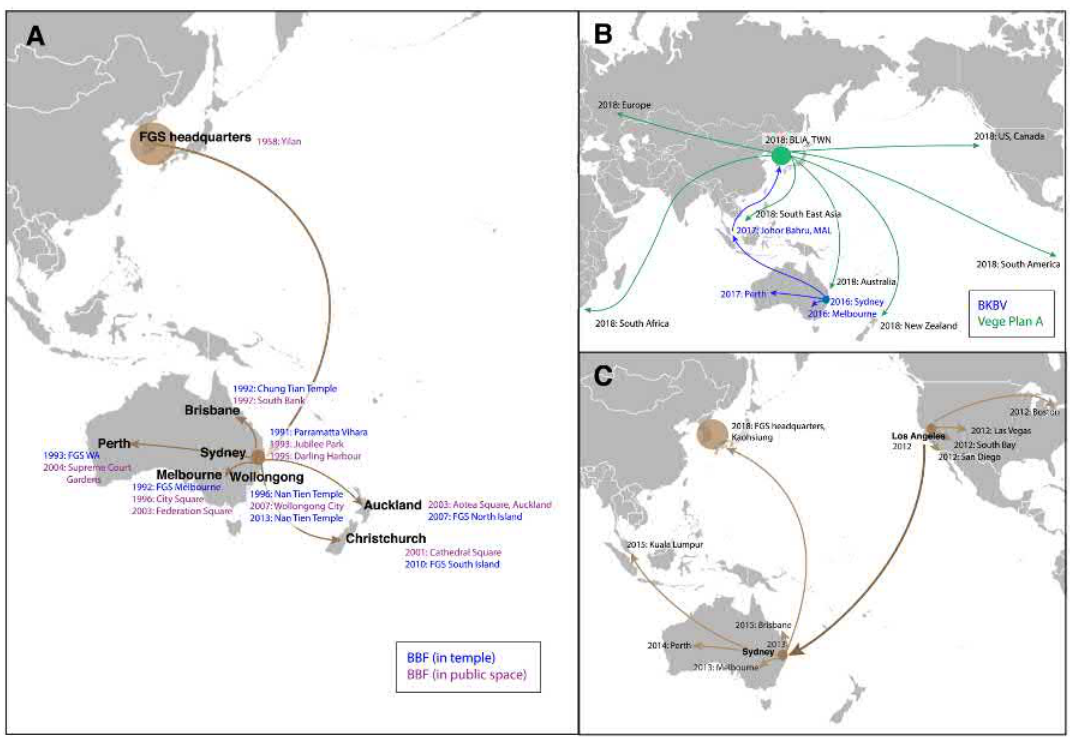
Figure 3: Multidirectional flows in the FGS network. A . Flow from FGS headquarters in Taiwan to its regional centre and branchtemplesinAustraliaandNewZealand.TheideatocelebrateBBFinpublicspacesoriginatedfromFGSheadquarters in 1958 in Yilan, Taiwan, and flowed to FGS Australia and New Zealand starting with celebrations in Jubilee Park in 1993 and then Darling Harbour, Sydney in 1995. B . Flow from FGS Australia and New Zealand to the worldwide FGS network. BKBV originated from Sydney in 2016 and became transformed into the global Vege Plan A event in 2018. C . BBEP flowed from Hsi Lai Temple, the regional centre of FGS North America to Nan Tien Temple, regional centre of FGS Australia and New Zealand, and then other parts of